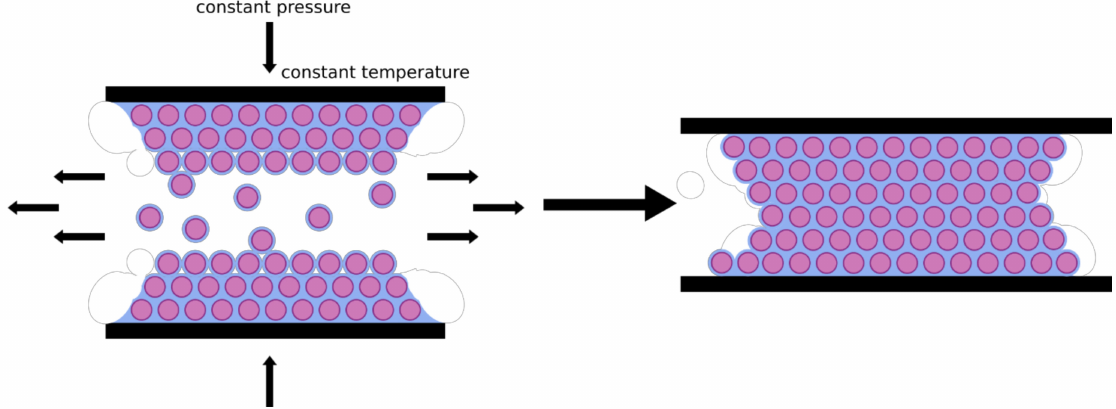
Figure 4. Fabrication of colloidal crystals by using the melt-shear